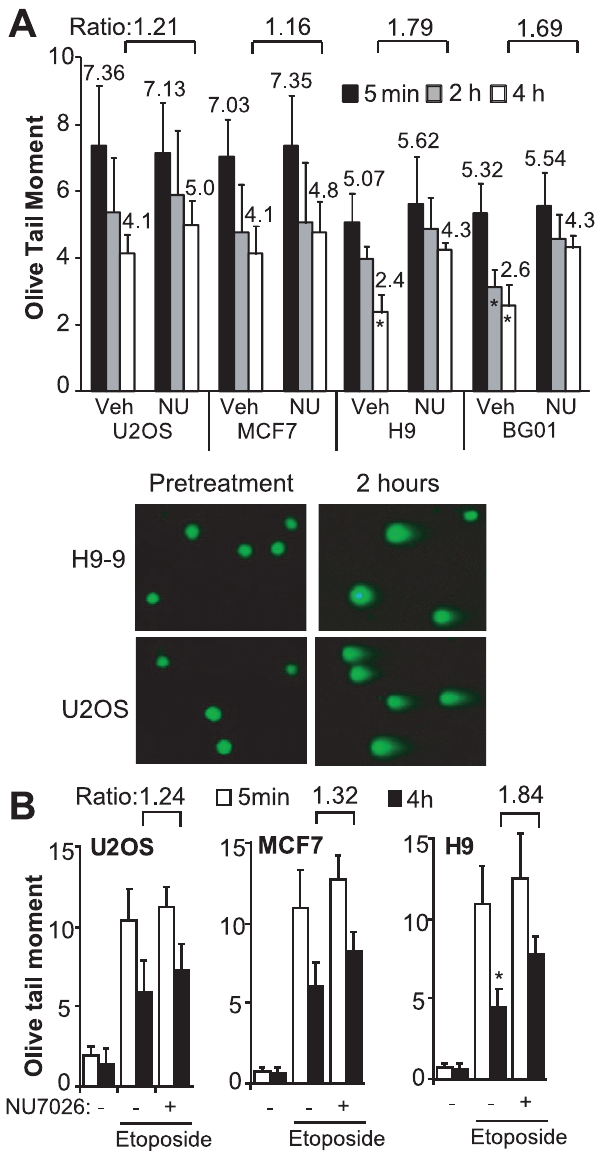
Figure 5. DNA-PKcs-dependent and -independent repair after low-dose IR. A . Neutral comet assay was performed after irradiation with 2 Gy in the presence of NU7026 (Nu) or vehicle (Veh) and the olive tail moment was calculated for at least 50 cells for each condition at the indicated time points. Error bars indicate one standard deviation. Indicated ratios are between olive tail moments for the same cell line in the presence of NU7026 or vehicle. * indicates p , 0.01 compared with same cell line and time point treated with vehicle. B . Comet assays were performed after treatment with etoposide or vehicle (-).